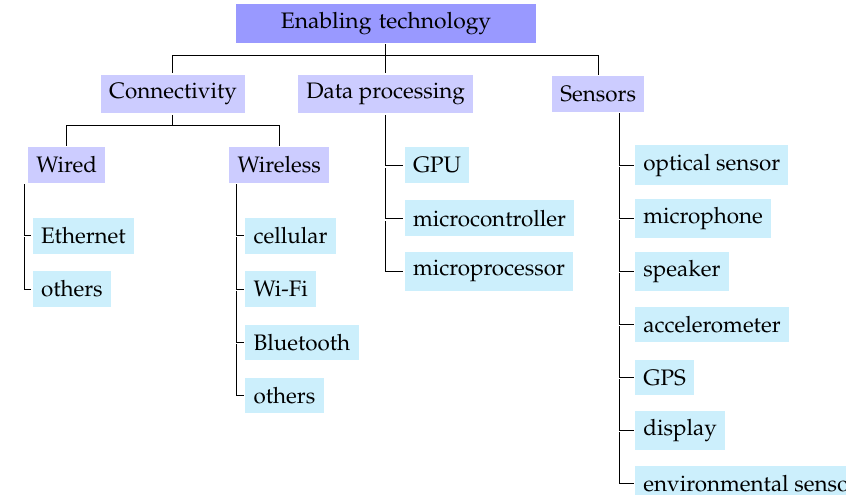
Figure 5. Enabling technology taxonomy for computer systems, including connectivity principle, data processing approach and use of